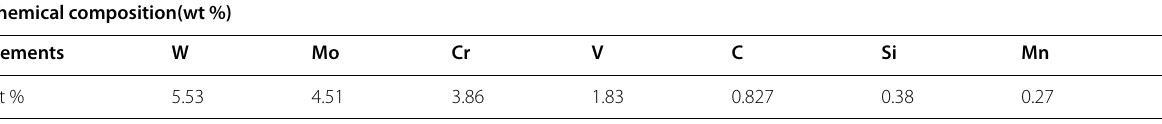
Mo Cr V ) powder 6 5 4 2